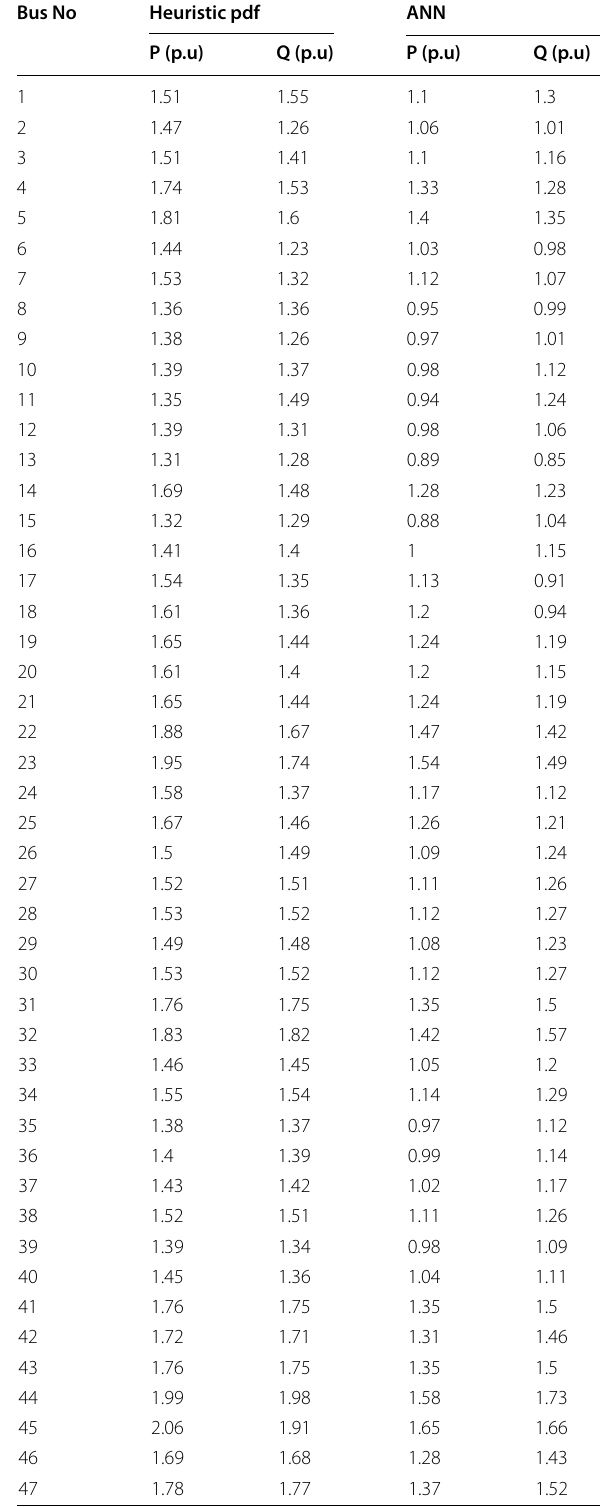
Table 11 Modified value of Weight